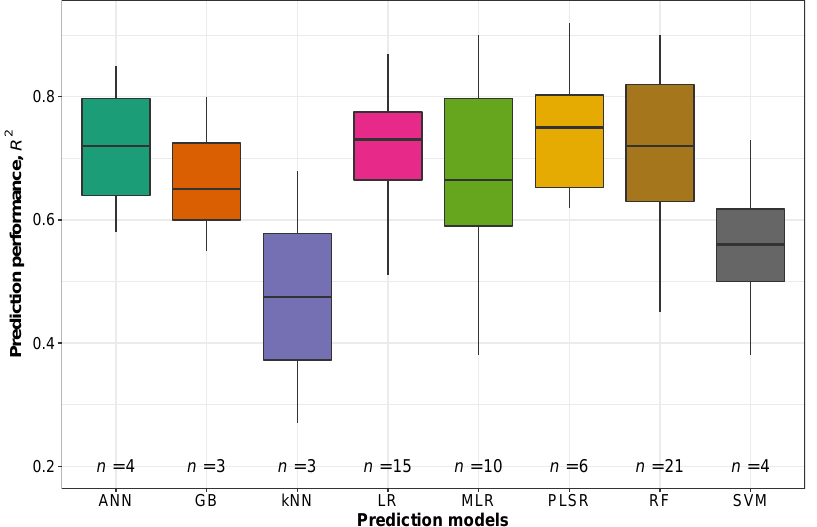
Figure 4. Box plot of prediction performance ( R 2 ) for the eight most-used regression and machine learning methods. ANN—artificial neural network, GB—gradient boosting, kNN—k-nearest neigh- bor, LR—linear regression, MLR—multiple linear regression, PLSR—partial least squares regression, RF—random forest, and SVM—support vector